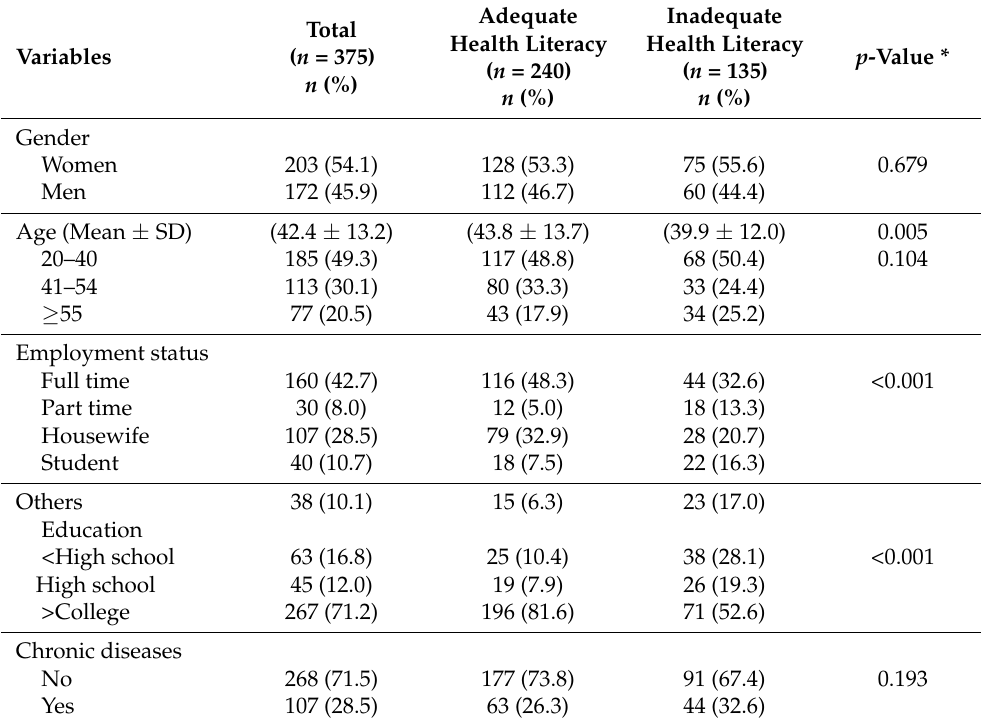
Table 1. Demographic characteristics of participants by health literacy